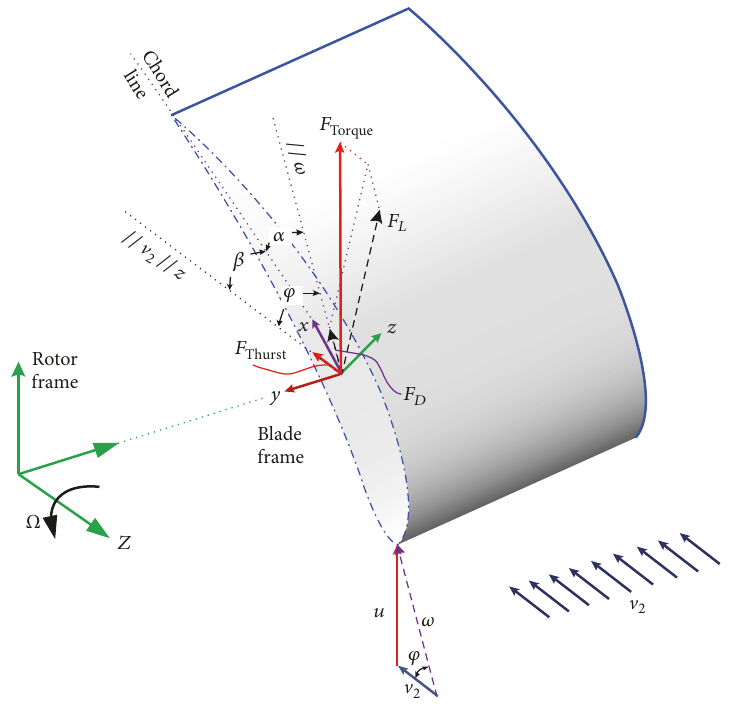
Figure 4: Aerodynamic forces on blade